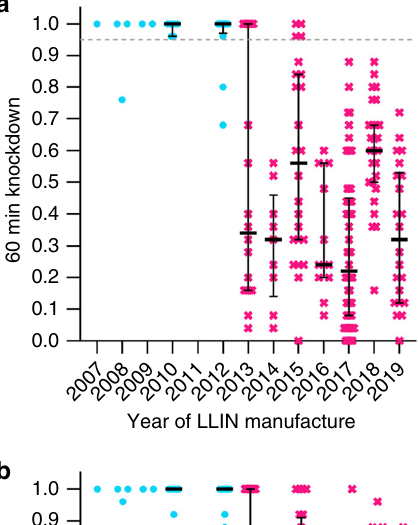
Fig. 1 WHO cone-bioassay data for new and unused LLINs by year of manufacture. a 60 min knockdown rates of new LLINs. b Adjusted 24 h mortality rates of new LLINs. c Correlation between 60 min knockdown and adjusted 24 h mortality rates. The dashed lines indicate 95% 60 min knockdown ( a and c ) and 80% 24 h mortality ( b and c ) rates. The colours and symbols differentiate between 2007 – 2012 LLINs (turquois circles) and 2013 – 2019 LLINs (magenta crosses). Error bars in panels a and b are medians and interquartile ranges (only presented for sample sizes of n ≥ 7). Each data point represents one bioassay result conducted on one individual, independent LLIN (number of LLINs tested per year given in Table 1 in the ‘ LLINs tested ’ column). If the bioassay was valid (negative control mortality <10%), bioassays on individual LLIN samples were not repeated. Source data for this Figure are provided as a Source Data fi le.